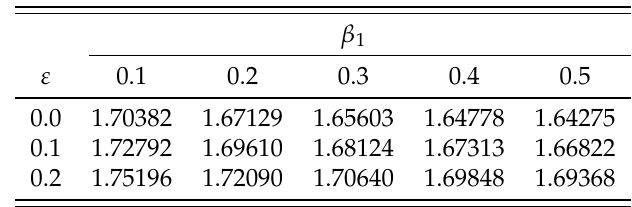
Table 5. Z (Heat transfer coefficient) as a function of β 1 and ε . Here x = 0.1, Q = − 1.2, β 2 = 0.2, Br = 0.5, ϕ = π /4, M = 4, λ 1 = 1.